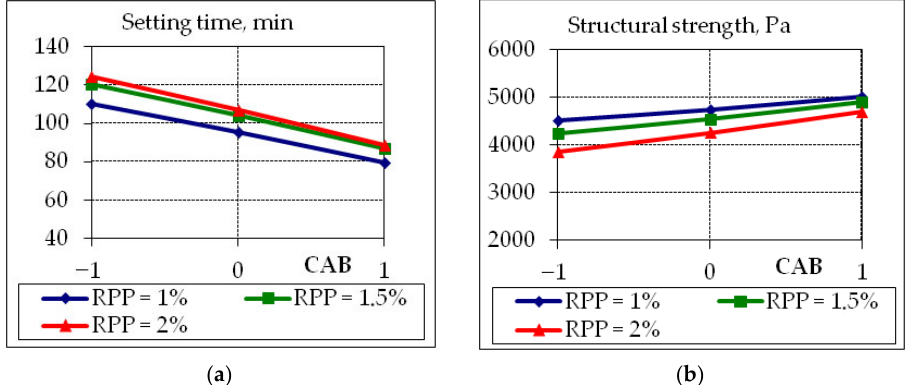
Figure 7. Graphical dependences of setting time ( a ) and structural strength ( b ) 30 min after mixing of fly ash concrete suitable for 3D printer, where CAB content −1 = 15%; 0 = 17.5%; +1 = 20%. The addition of RPP to the mixtures for the 3D printer allows to increase the setting time (Figure 7a) or the so-called “printing window” by 8–15%. However, this has a negative consequence associated with a decrease in structural strength, which decreases at the maximum water consumption within the experiments (Figure 7b). Structural strength increases more significantly by 12–15% with an increase in CAB content compared to its decrease with an increase in the amount of RPP by 8–10%.